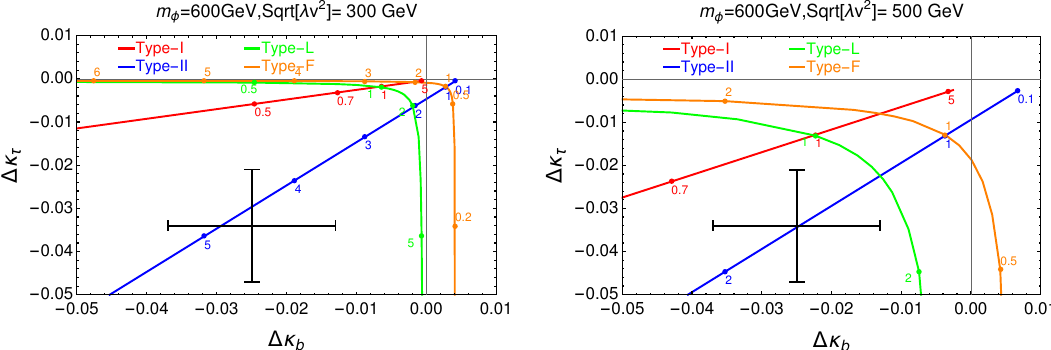
Figure 10 . Loop corrections of (cid:1) (cid:20) (cid:28) vs (cid:1) (cid:20) b for four di(cid:11)erent types of 2HDM, for m (cid:30) = 600 GeV, p with (cid:21)v 2 = 300 GeV (left panels), and 500 GeV (right panels). The values of tan (cid:12) are indicated in the plots with dots. The black cross indicate the estimated experimental errors with a random central